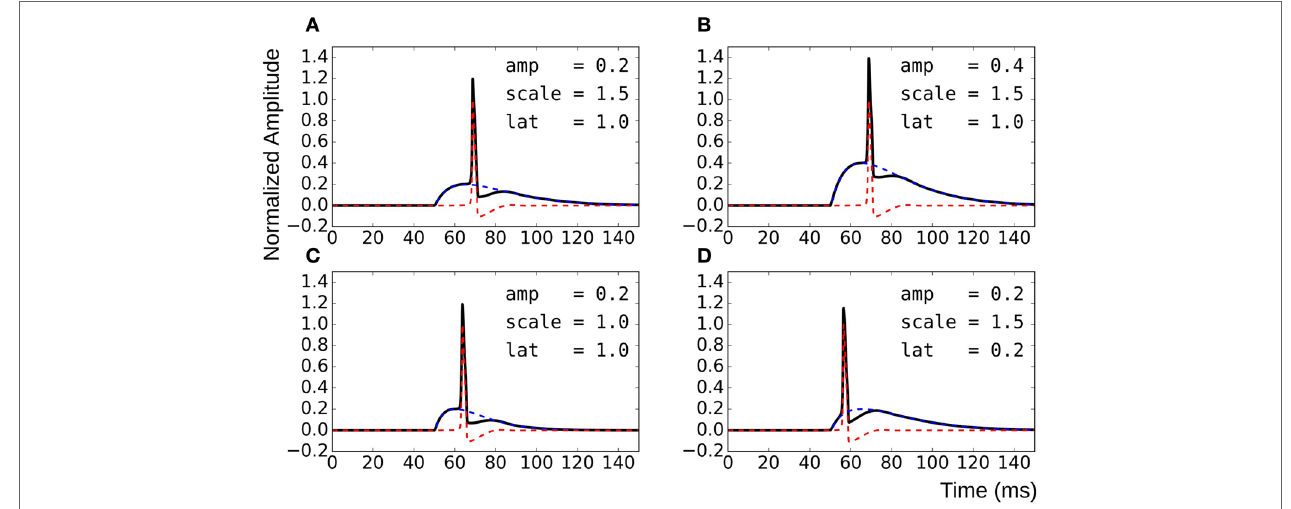
FIgURe 4 | Method for generating test data by varying superposition of a modulated STD with an AP profile. (A) reference panel, (B) change in STD amplitude, (C) change in STD time course, and (d) change in AP